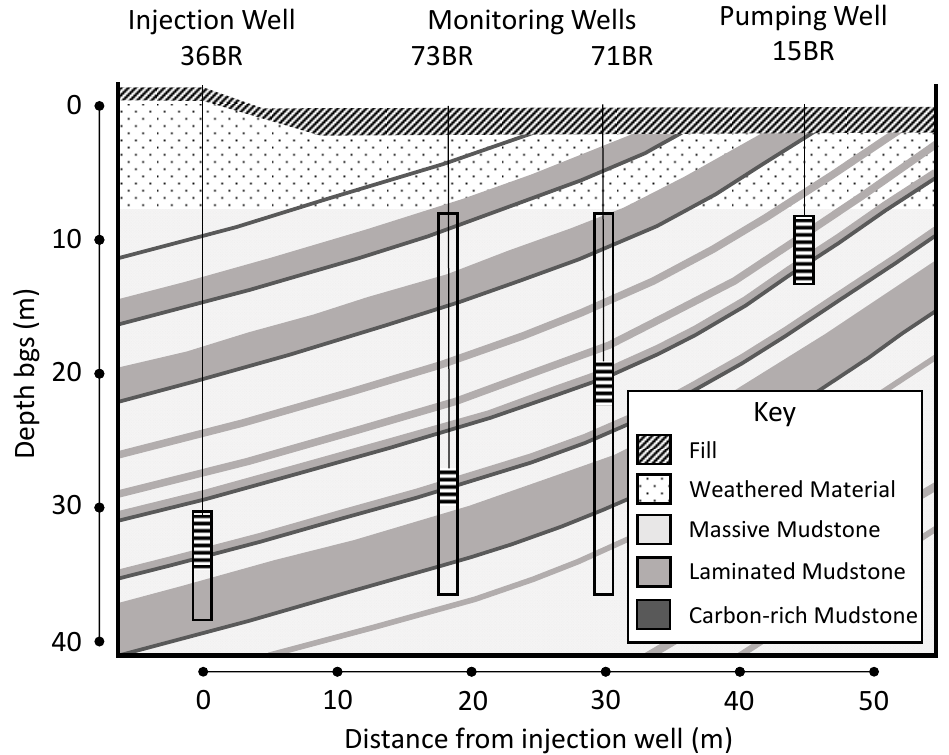
Figure 5. Cross section showing primary flow path from injection well 36BR to pumping well 15BR as indicated by the packer-isolated sampling intervals (horizontal line pattern). Adapted from Bradley et al. [96]. Geologic descriptions and primary flow path as noted by Révész et al. [68].